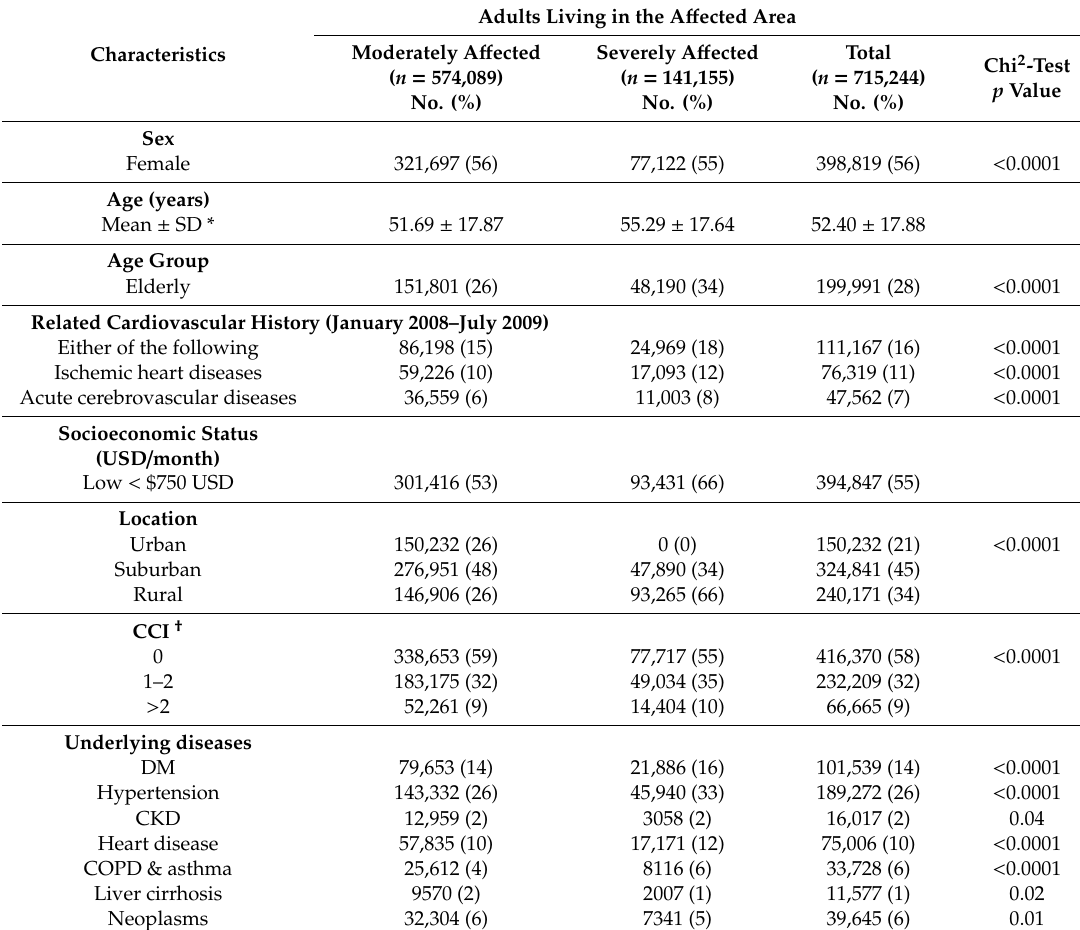
Table 1. Demographic and clinical characteristics of adults living between di ff erent severity of a ff ected areas before Typhoon